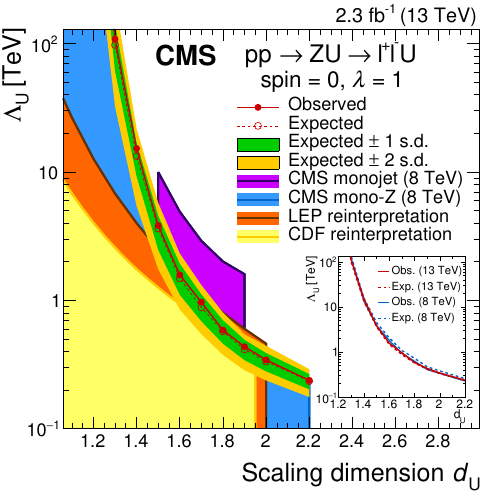
Figure 10 . The 95% CL lower limits on the e(cid:11)ective unparticle cuto(cid:11) scale (cid:3) U for a (cid:12)xed coupling (cid:21) = 1. The results from the CMS monojet [1] and mono-Z [2] searches, as well as a reinterpretation of LEP and CDF searches [3] are shown for comparison. The LEP results assume a coupling of unparticles to Z bosons and photons. The CDF (CMS) monojet result is based on a gluon- unparticle coupling operator (gluon- and quark-unparticle coupling operators). The inset compares p the expected and observed limits for the CMS mono-Z analyses at s = 8 and 13 TeV. Note that the cuto(cid:11) scales (cid:3) U for di(cid:11)erent operators do not have to be identical. Consequently, the comparison shown here with the results other than the CMS 8 TeV mono-Z analysis is only qualitative. In the original paper, (cid:12)gure 10 was incorrect. The correct (cid:12)gure is shown